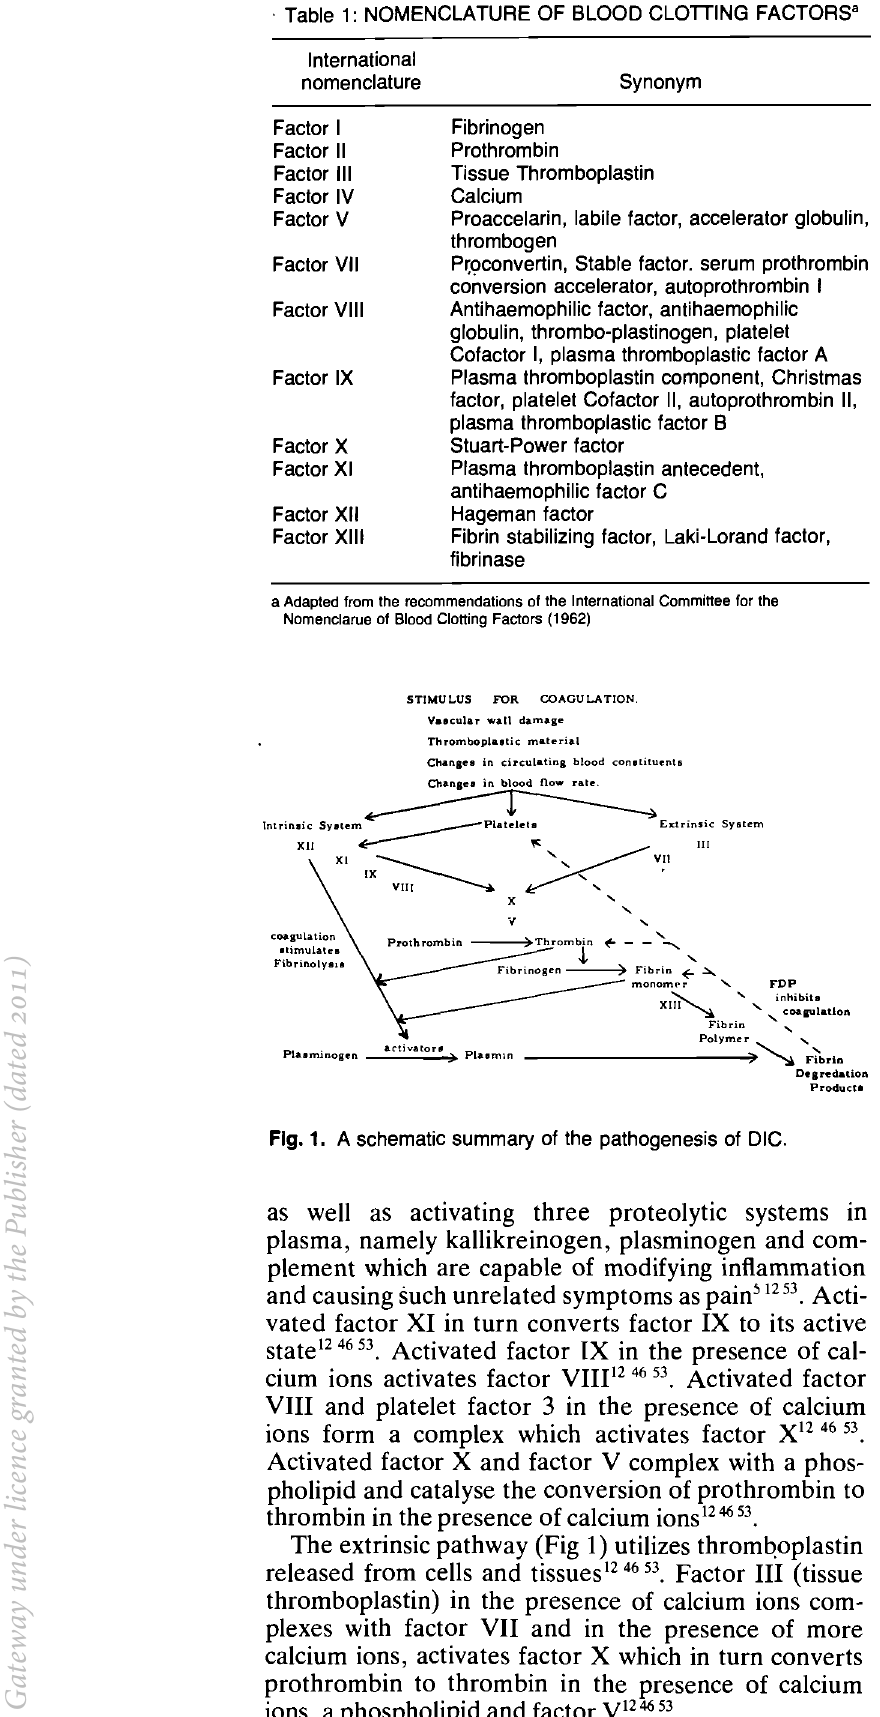
. Table 1: NOMENCLATURE OF BLOOD CLOniNG FACTORS·